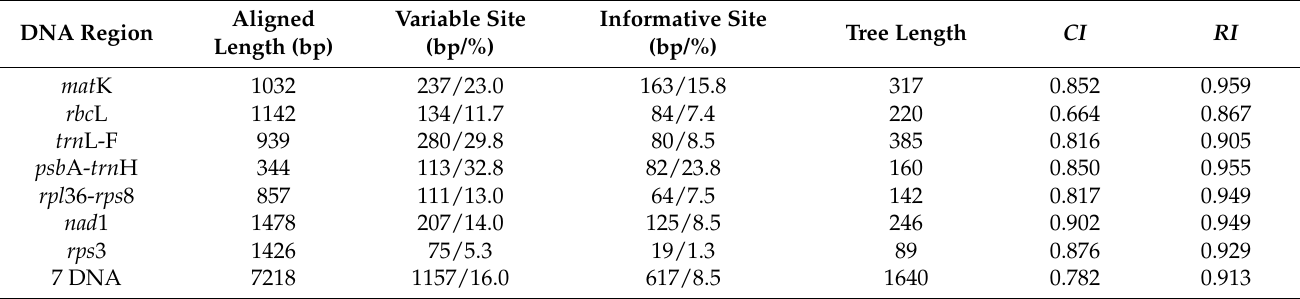
Table 4. Informative parameters for the seven molecular